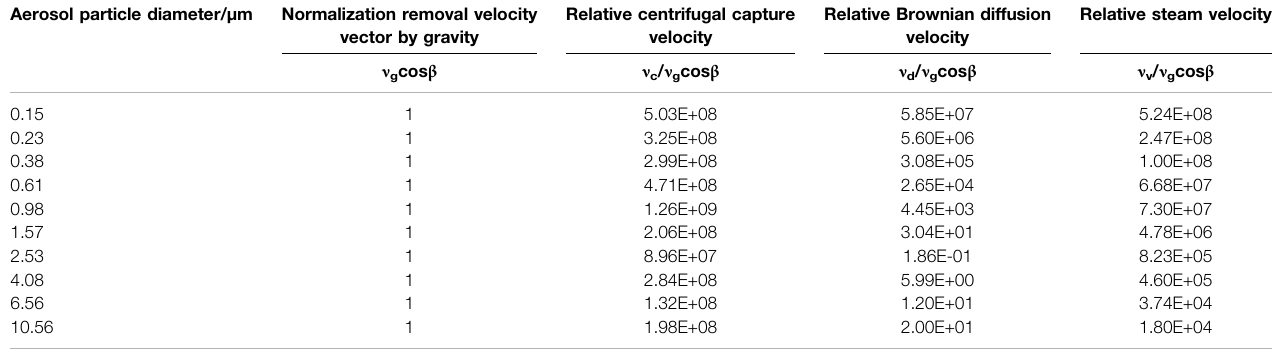
TABLE 7 | Correlation velocity of each sedimentation mechanism in the bubble rising zone. Aerosol particle diameter/ μ m